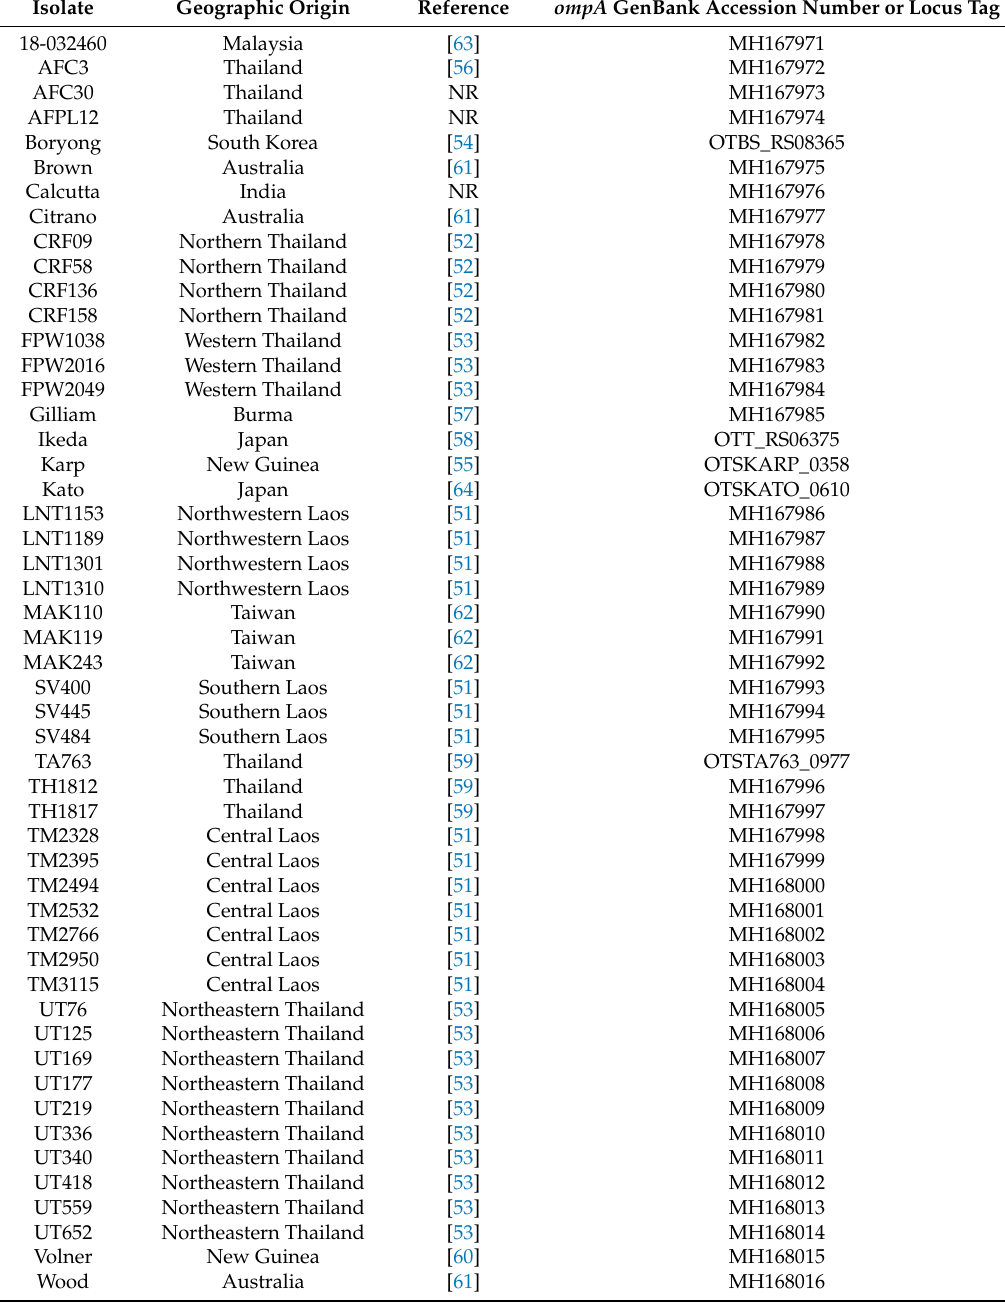
Table 1. O. tsutsugamushi isolates used in this